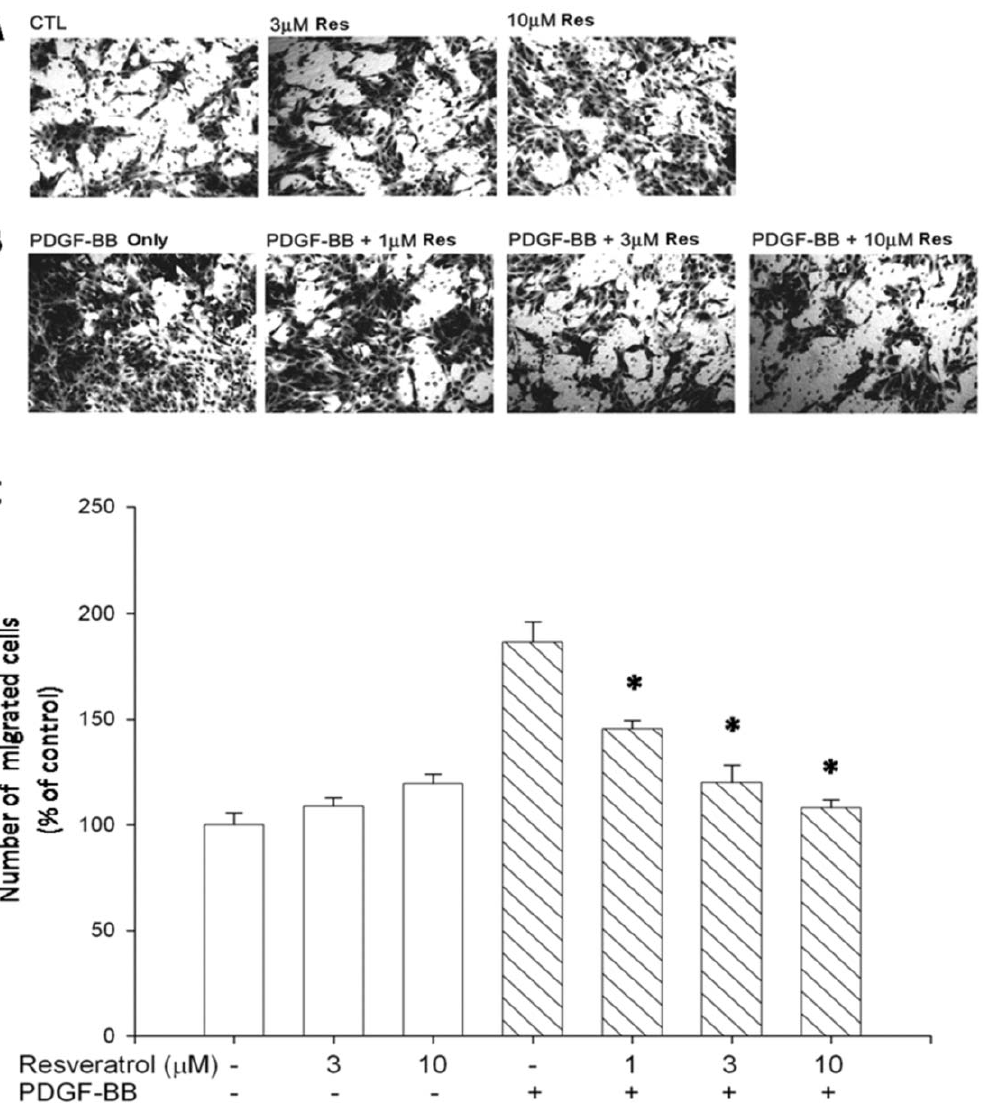
Figure 2. Transwell migration assay showed that PDGF-BB-induced ARPE19 cell migration was inhibited by resveratrol. Transwell inserts were coated with fibronectin (0.3 mg). ARPE19 cells (5 6 10 4 in 200 m l) were seeded in the upper chamber in the absence or presence of resveratrol. The inserts were assembled in the lower chamber, which was filled with 600 m l serum-free medium without PDGF-BB (A) and containing PDGF-BB (20 ng/ml) (B), and preincubated with various concentrations of resveratrol for 30 mininutes at 37 u C. After incubating for 5 hours at 37 u C, fixation was performed. ARPE19 cells that migrated to the underside of filter membrane were photographed (A, B) and counted by phase contrast light microscope under high power field (magnification, 100 6 ), (C). All experiments were conducted in duplicates and similar results were repeated four times. The results are expressed as percentage of control and represent mean 6 standard errors (SE) of the eight experiments. *p , 0.05 significantly differs from PDGF-BB-stimulated cells (the fourth